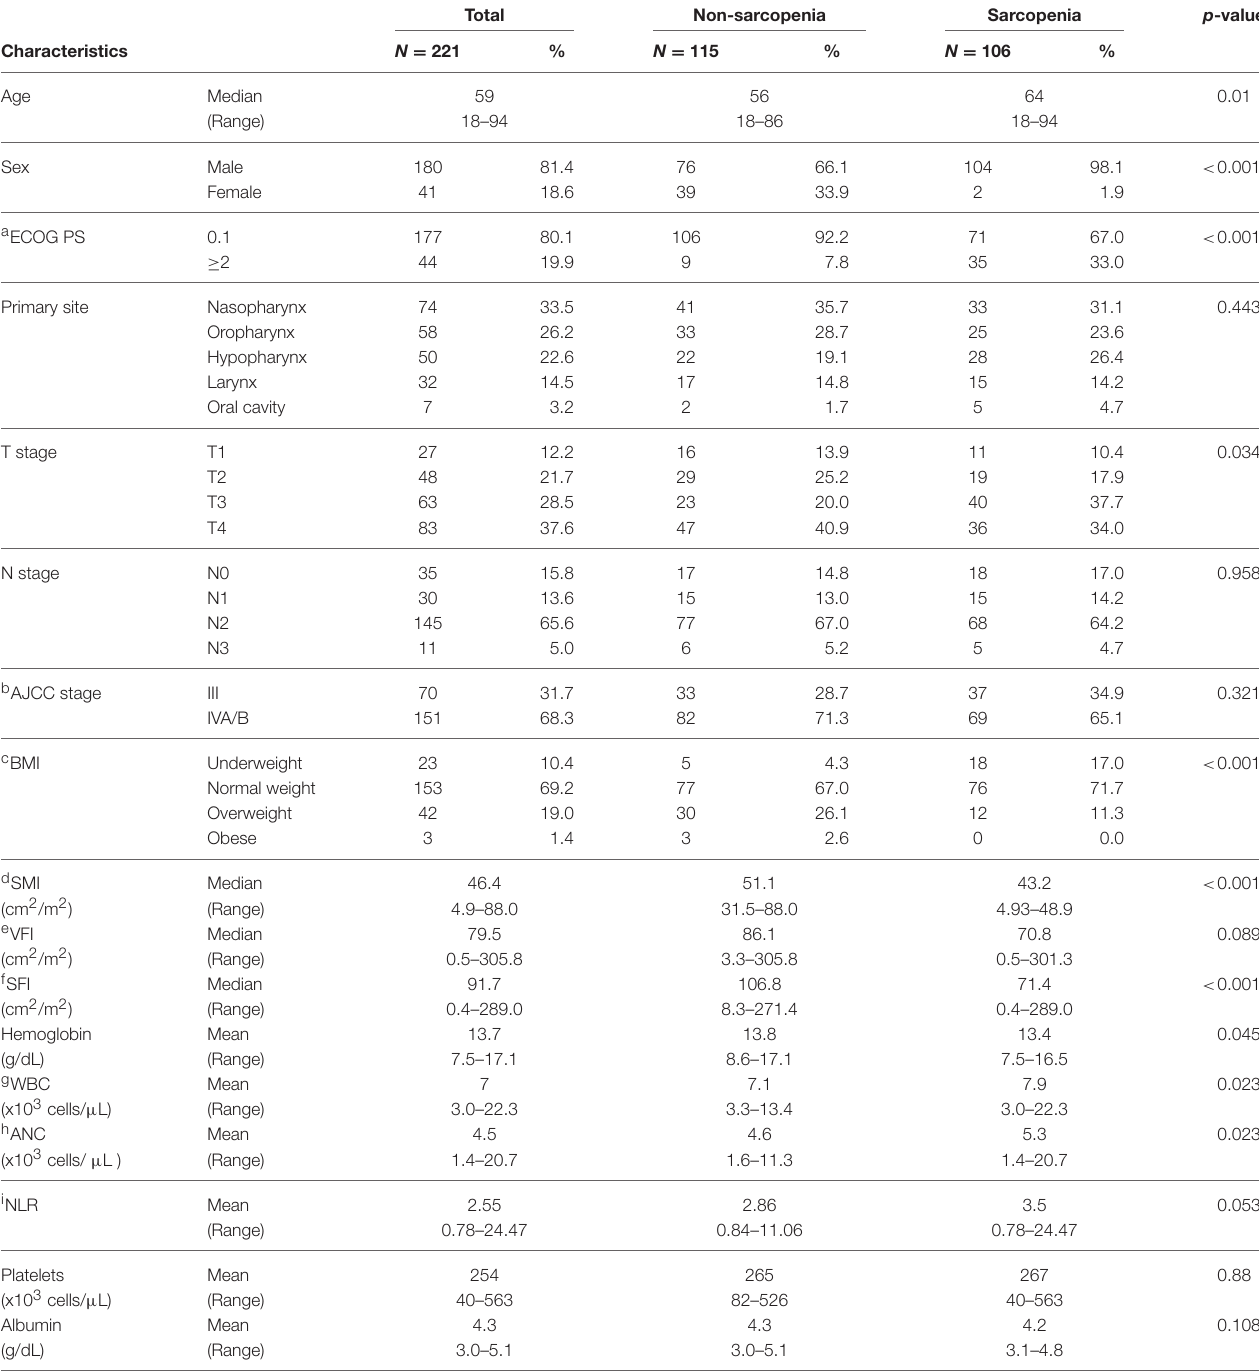
TABLE 1 | Patient